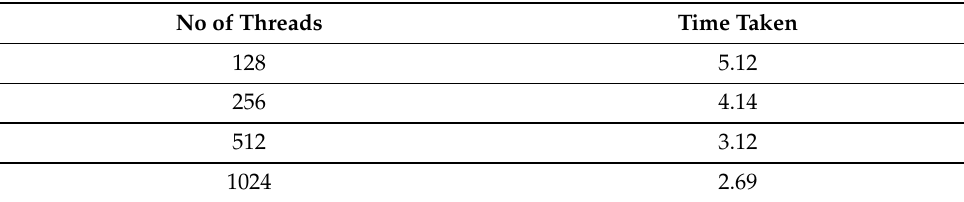
Table 2. Number of threads versus time taken.